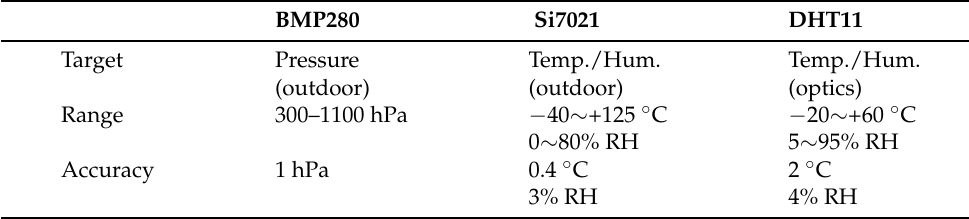
Table 3. SUTO-Solar environmental